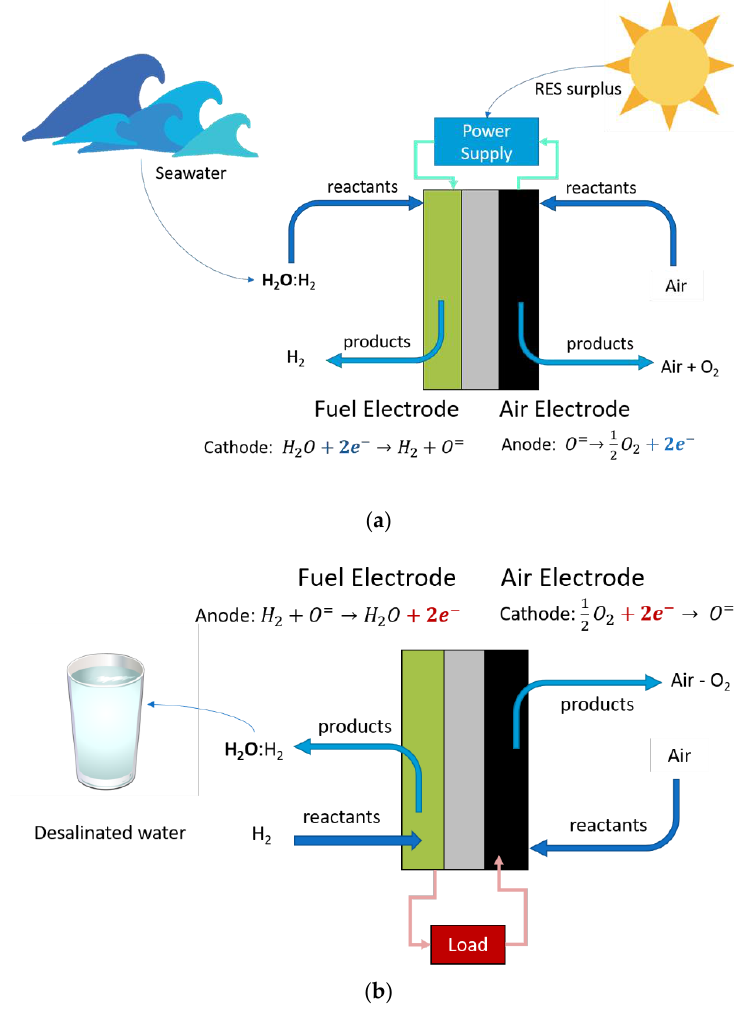
Figure 1. rSOC operation scheme: ( a ) Electrolysis (SOE), ( b ) Fuel cell